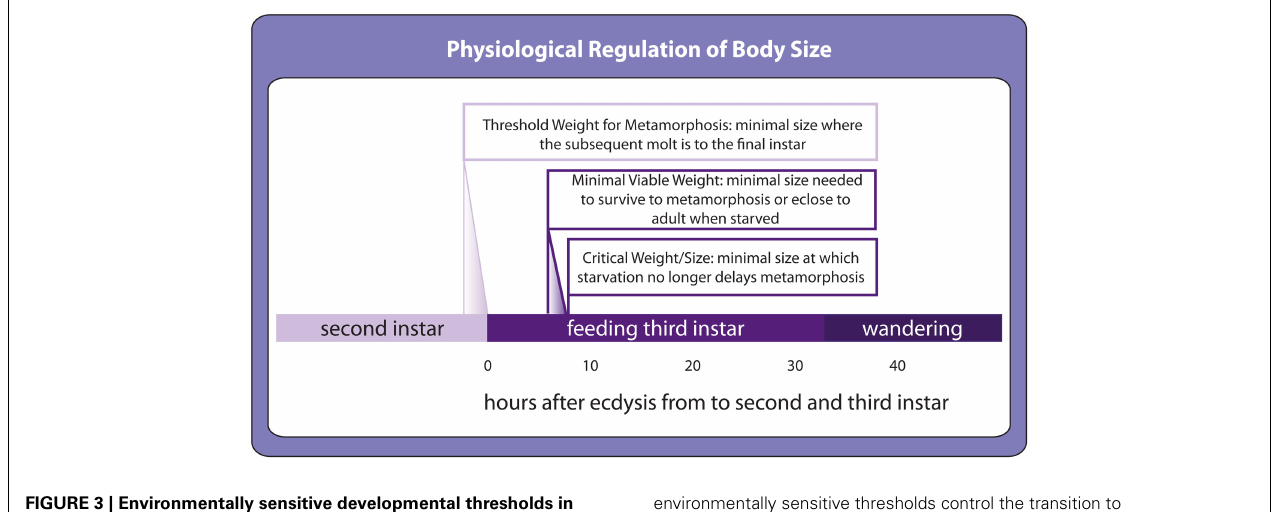
FIGURE 3 | Environmentally sensitive developmental thresholds in the second and third instar as defined in Drosophila . Toward the end of the second instar, a size-dependent threshold called threshold size for metamorphosis determines whether the following molt will be the final larval molt before metamorphosis.The precise timing for this event has not yet been determined. At the beginning of the third instar,